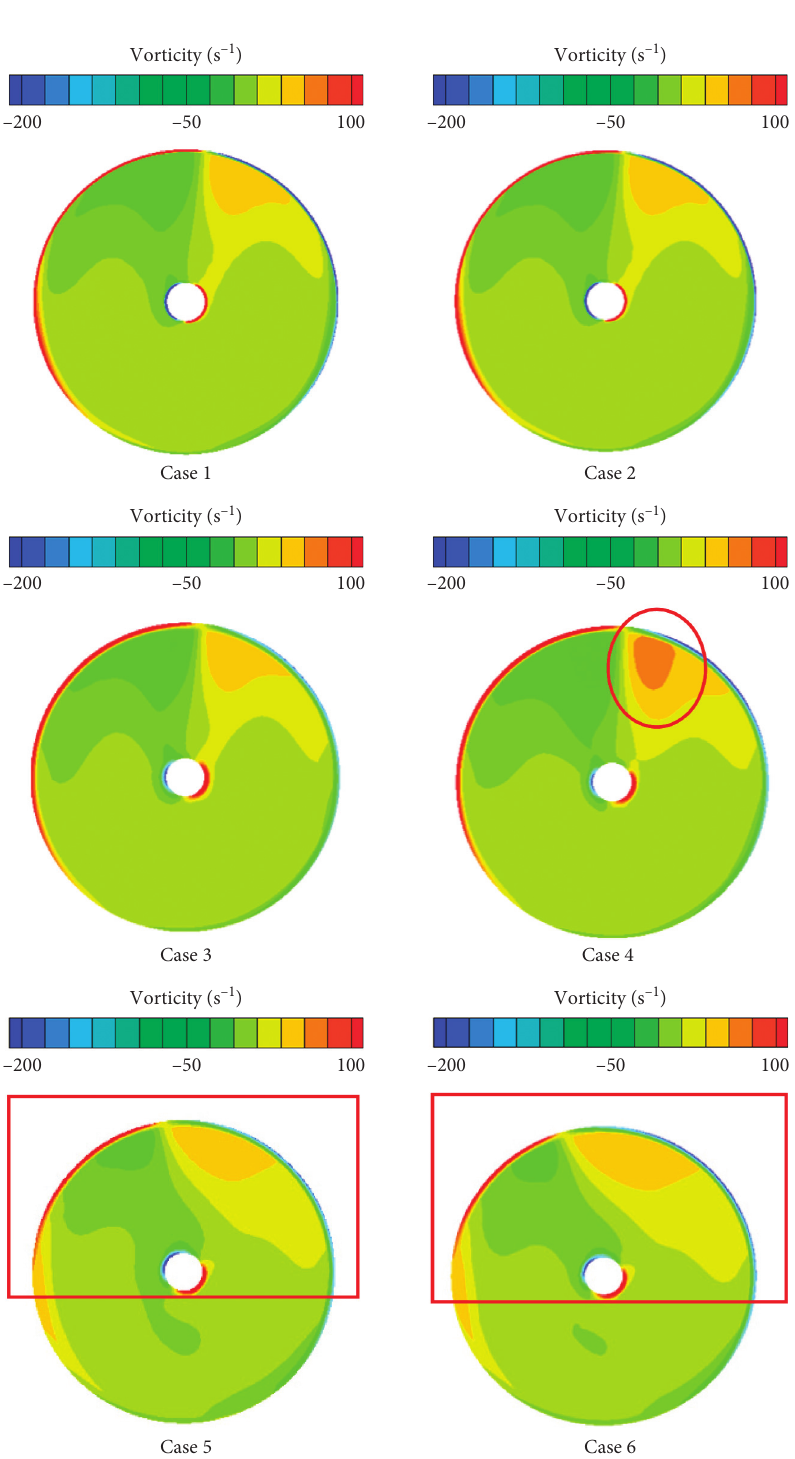
Figure 12: Cloud diagram of vorticity distribution at the exit of the runner with different runner